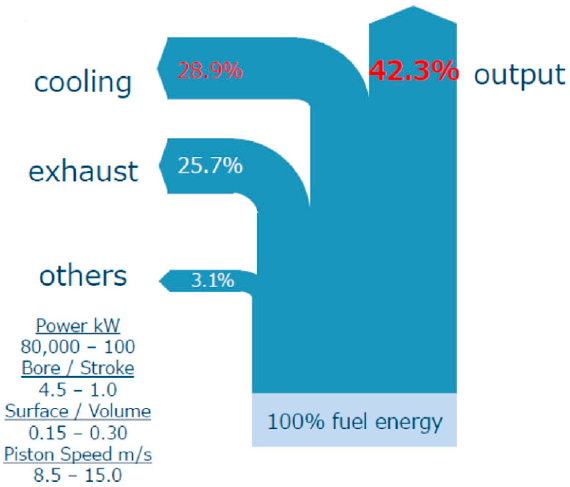
Figure 18. Energy distribution of a diesel engine [425].